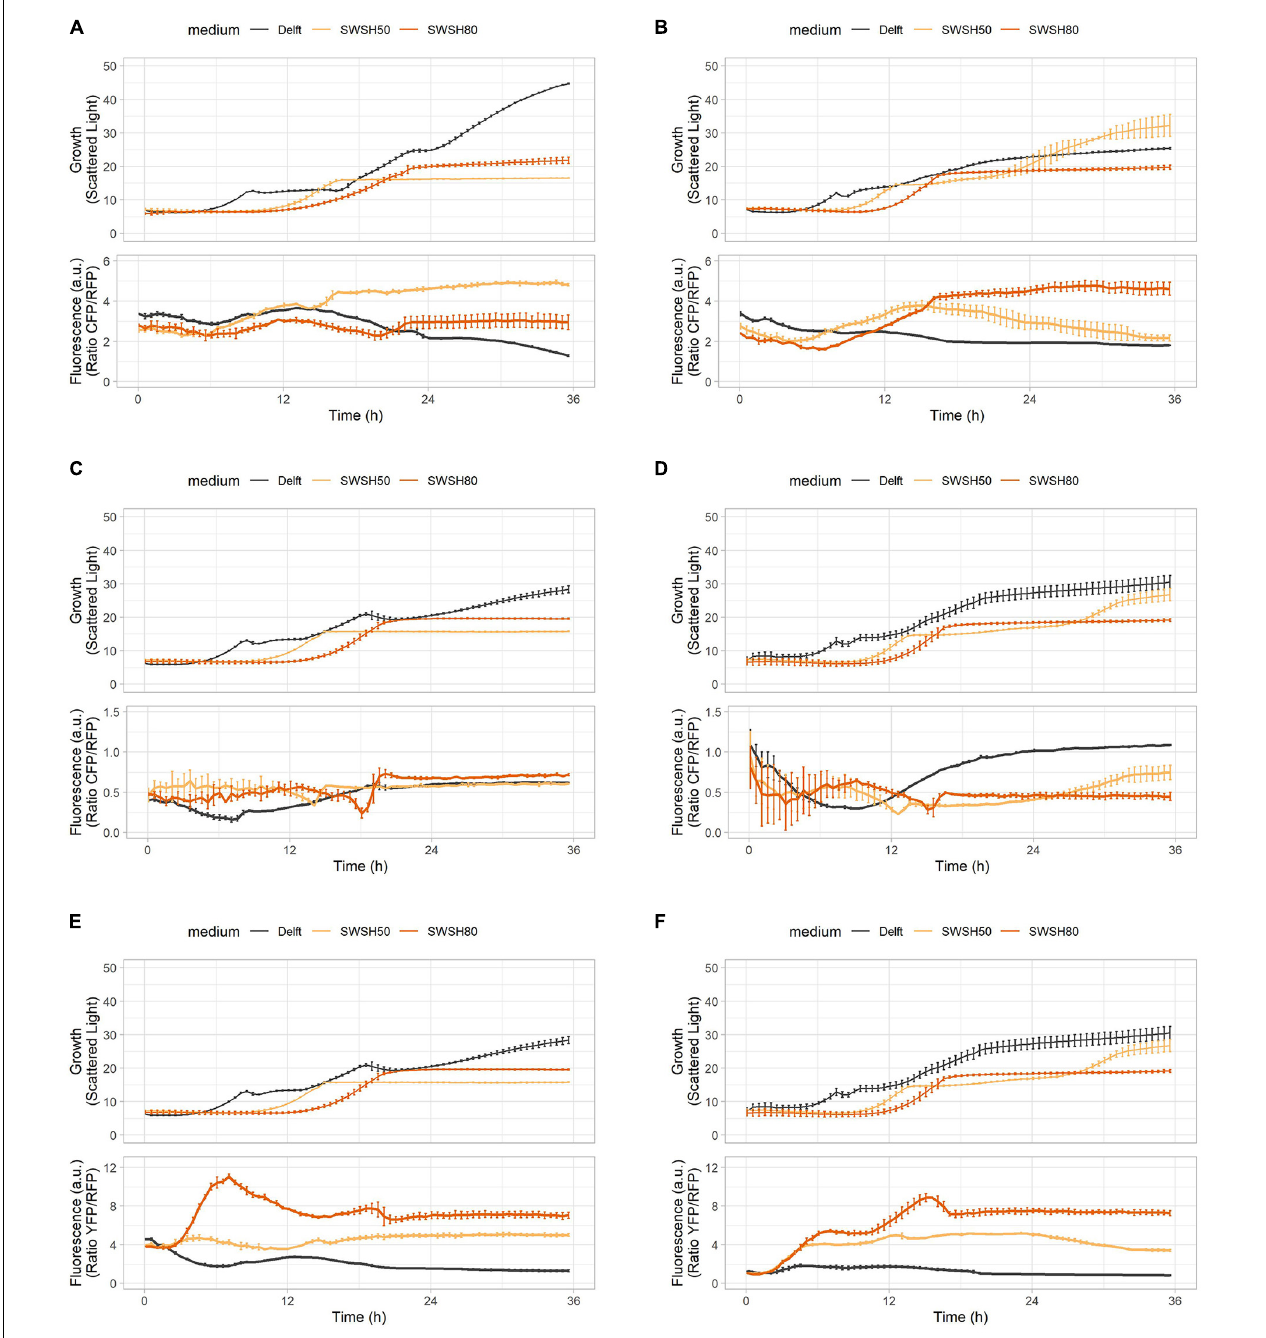
FIGURE 8 | Oxidative stress, ribosome production, and glycolytic flux during growth in synthetic wheat-straw hydrolysate (SWSH). (A,B) Growth curves and ribosome production for (A) CEN.PK113-7D and (B) Ethanol Red strains harboring the RibOx biosensor. (C,D) Growth curves and glycolytic flux for (C) CEN.PK113-7D and (D) Ethanol Red strains harboring the GlyOx biosensor. (E,F) Growth curves and oxidative stress for (E) CEN.PK113-7D and (F) Ethanol Red strains harboring the GlyOx biosensor. Cells were grown in Delft medium (black line), SWSH diluted at 50% with Delft medium (SWSH50; orange line), and SWSH diluted at 80% with Delft medium (SWSH80; red